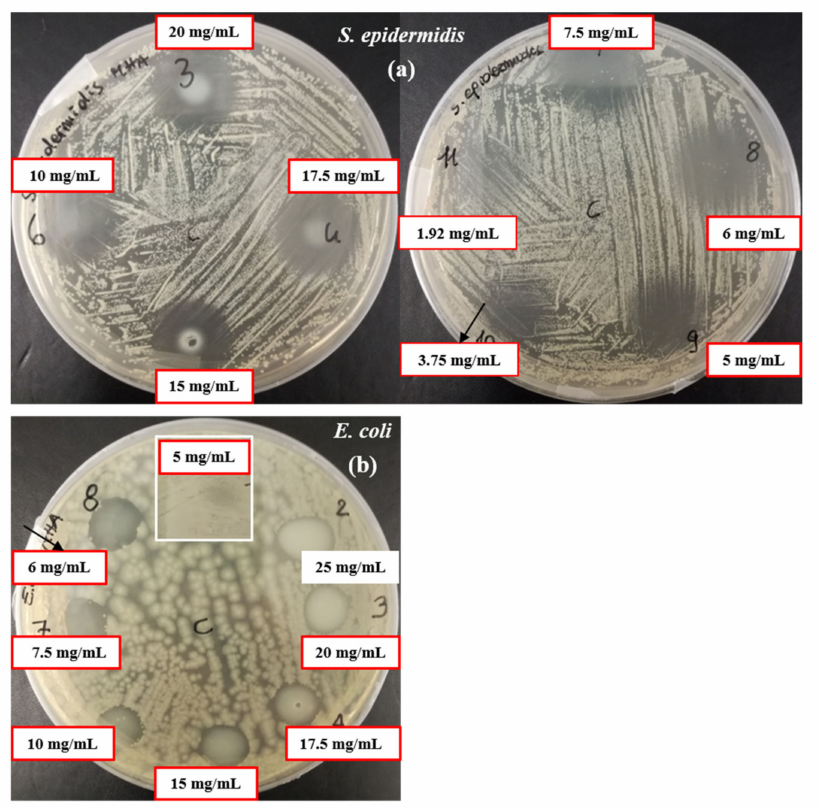
Figure 10. Modified Kirby–Bauer agar diffusion test against S. epidermidis ( a ) and E. coli ( b ). Red frames indicate the n-ZnO concentrations tested against both microorganisms. Black arrows indicate the lowest concentrations of ZnO that inhibit the bacterial growth, 3.75 and 6 mg/mL, for S. epidermidis and E. coli respectively.